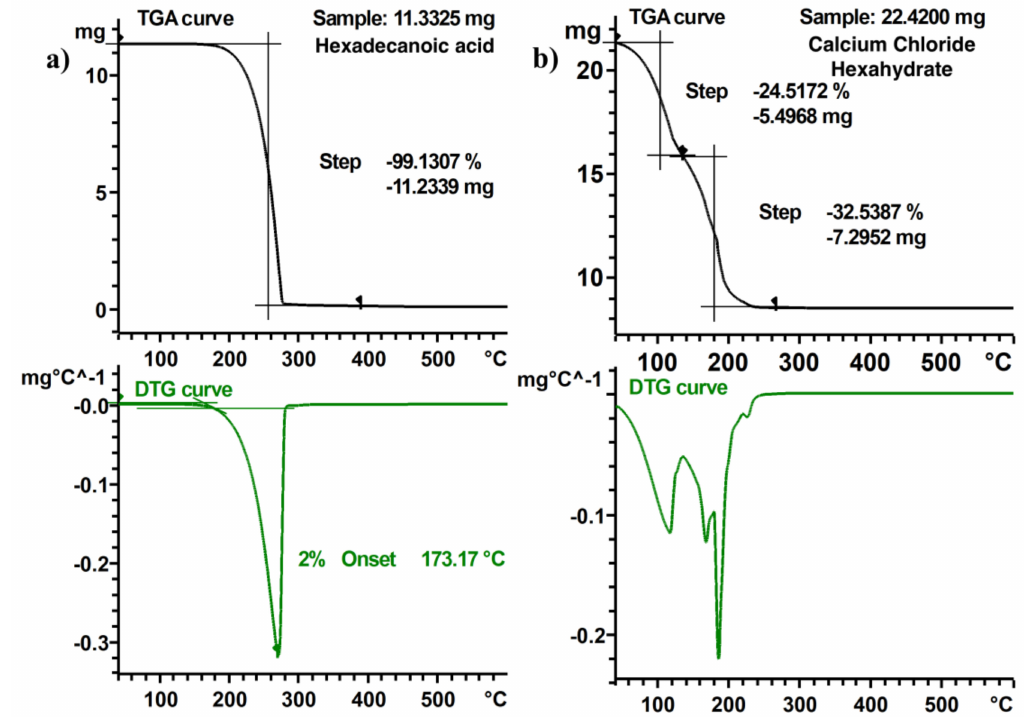
Figure 11. TGA and DTG curves of ( a ) hexadecanoic acid and ( b ) calcium chloride hexahydrate.